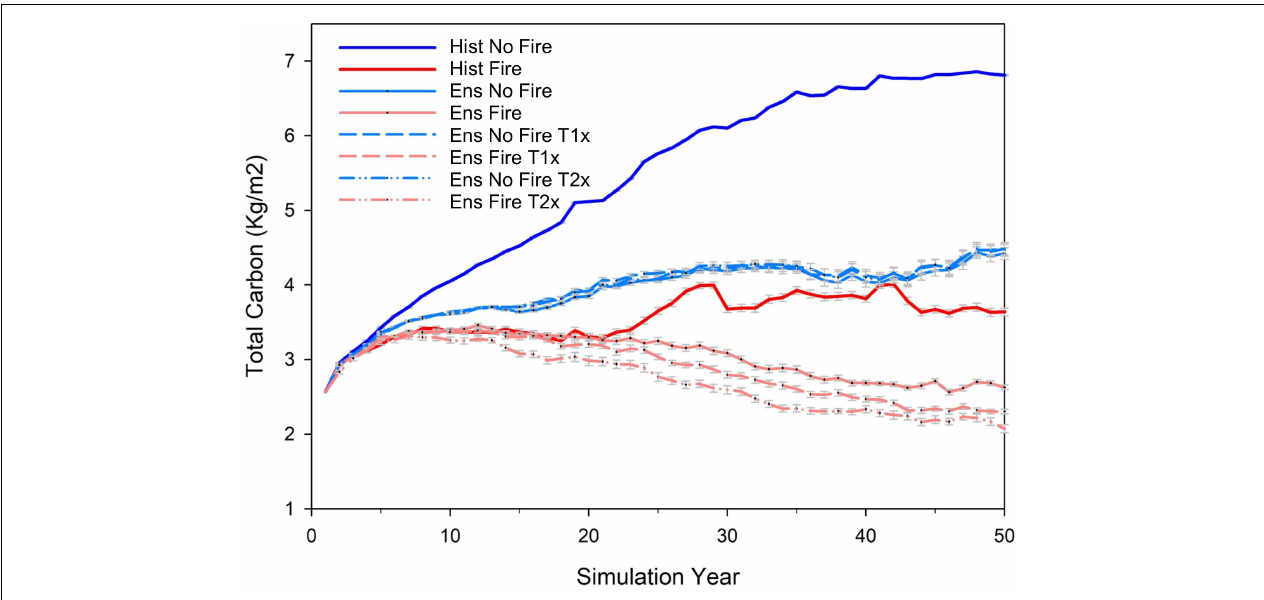
FIGURE 5 | Change in total ecosystem carbon over 50 years of simulation under historical (Hist) and projected model ensemble (Ens) climate with and without fire (Fire, No Fire) and with no fuel treatments, a single treatment (T1x), and double-entry fuel treatment